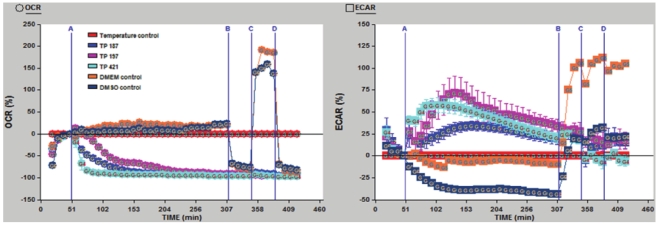
Oxygen consumption is decreased in TP treated MDA-MB-435 cells.OCR and ECAR were measured using the XF 24 Extracellular Flux Analyzer. Addition of TP compounds resulted in a decrease in OCR with a simultaneous increase in ECAR. The observed decrease in OCR was not affected by addition of inhibitors of ATP synthase, uncoupling agents or complex I inhibition. [Port A: TP compound (5 µM), Port B: Oligomycin (0.005 mg/mL), Port C: FCCP (1 µM) Port D: Rotenone (1 µM).